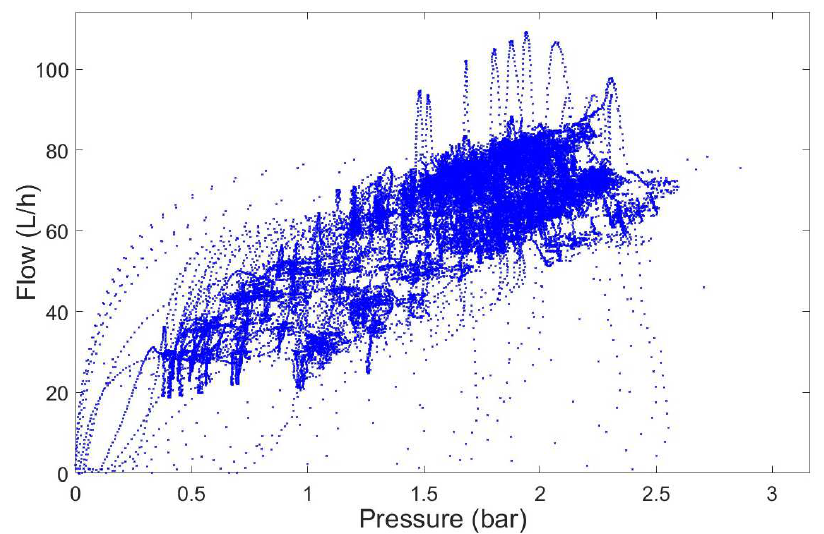
Figure 7. Operating working area of the pilot plant obtained for pump signal speed 0.5–3 V (108–650 rpm) and valve opening 65–80%.